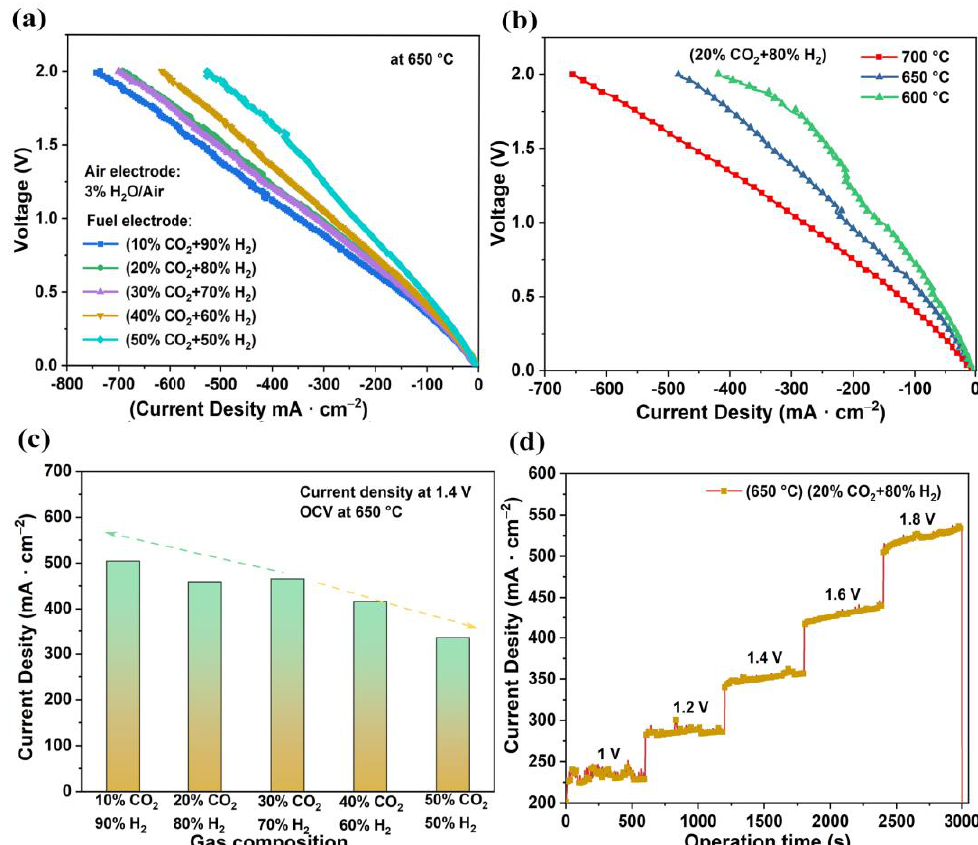
Figure 4. Electrochemical performances of tubular electrolysis cells. ( a ) Typical V-I graph of cell tested at different temperatures; wet air was injected into the air electrode, and the fuel electrode was supplied a mixture of H 2 and CO 2 . ( b ) Typical V-I curves of cell tested at 650 °C. ( c ) Relationship between electrolytic current density and gas composition at 1.4 V electrolytic voltage. ( d ) Short-term performance of CO 2 reduction at different voltages.